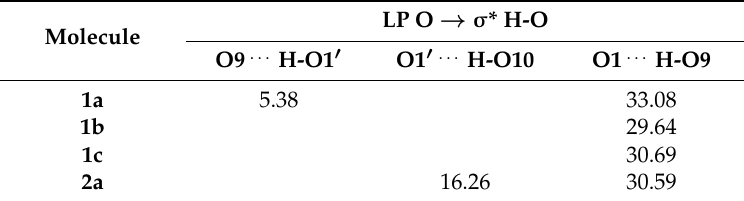
Table 9. Stabilization energies (kcal/mol) for selected NBO pairs (donor-acceptor) given by second-order perturbation energies for 1 and 2 .